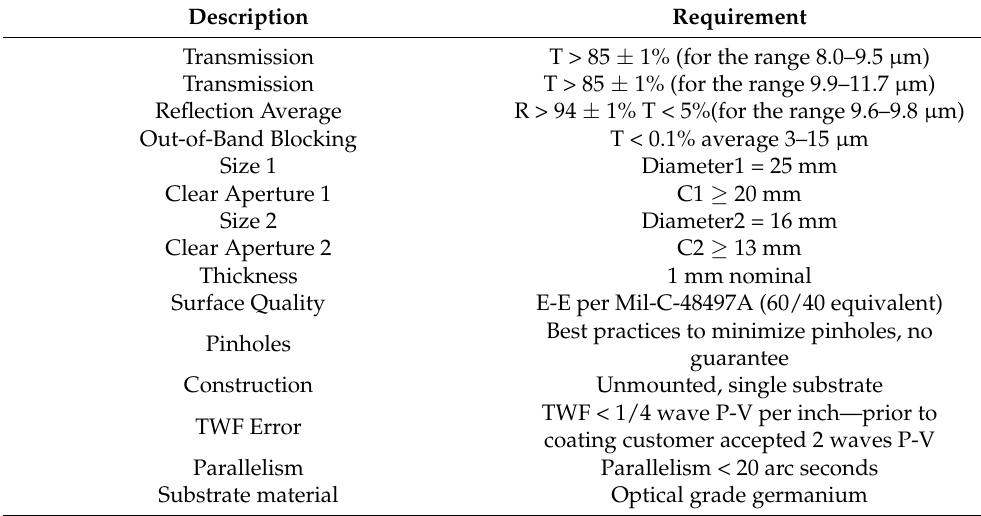
Table 3. Atmospheric transmittance equivalent analog filter coefficients.